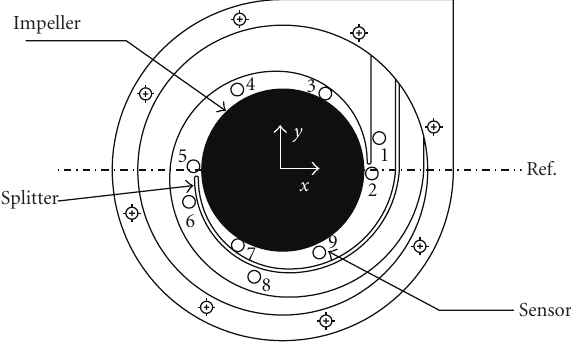
Figure 3: Model pump design and measuring locations.